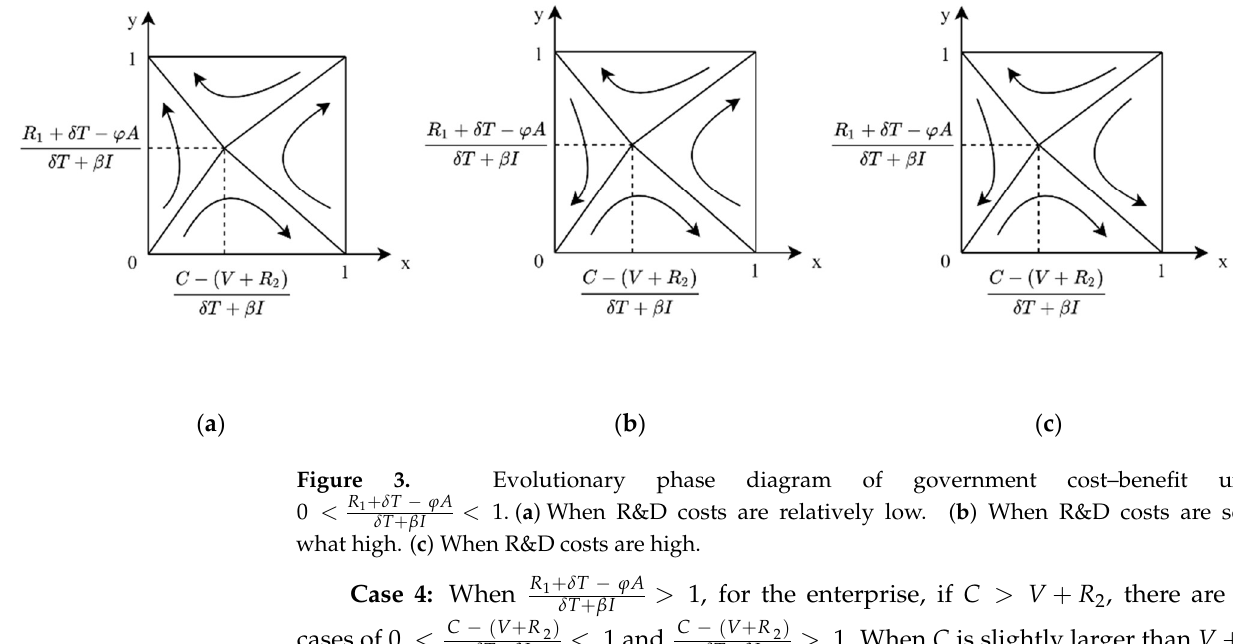
Case 4: When R 1 + δT - φA